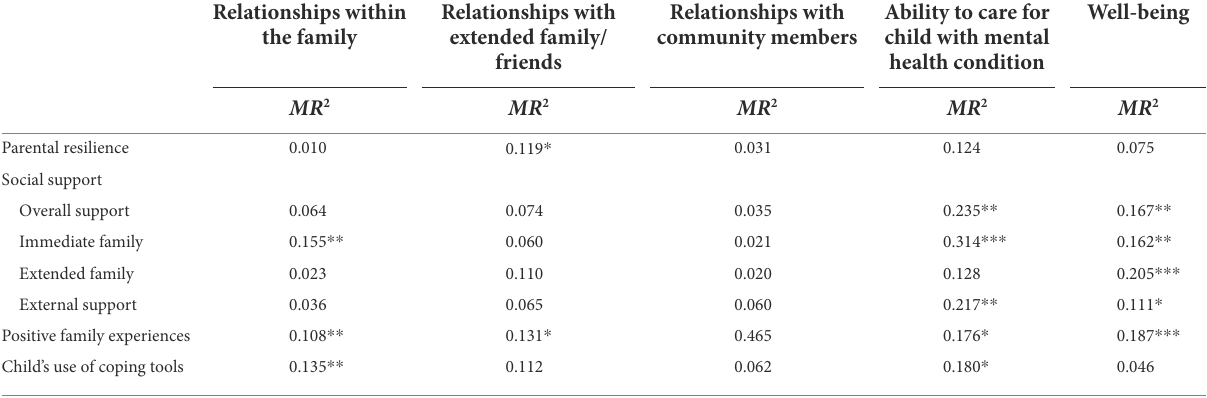
TABLE 3 The associations of protective factors with families’ relational functioning and parental well-being in adjusted models. Relationships within Relationships with Relationships with Ability to care for the family extended family/ community members child with mental friends health condition